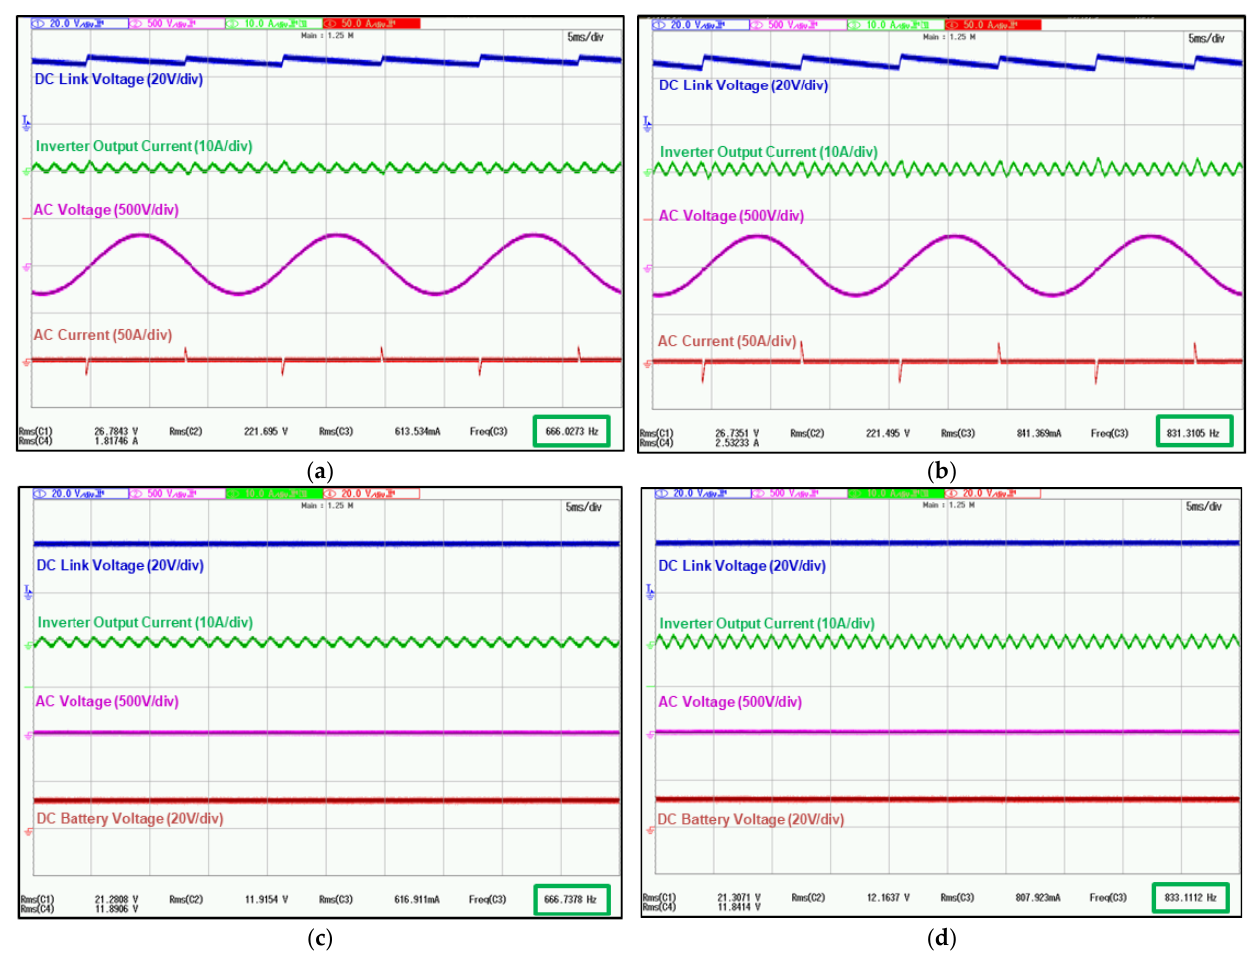
Figure 13. The waveforms of using AC power and DC power motor drive operation: ( a ) 40,000 rpm motor drive using AC power; ( b ) 50,000 rpm motor drive using AC power; ( c ) 40,000 rpm motor